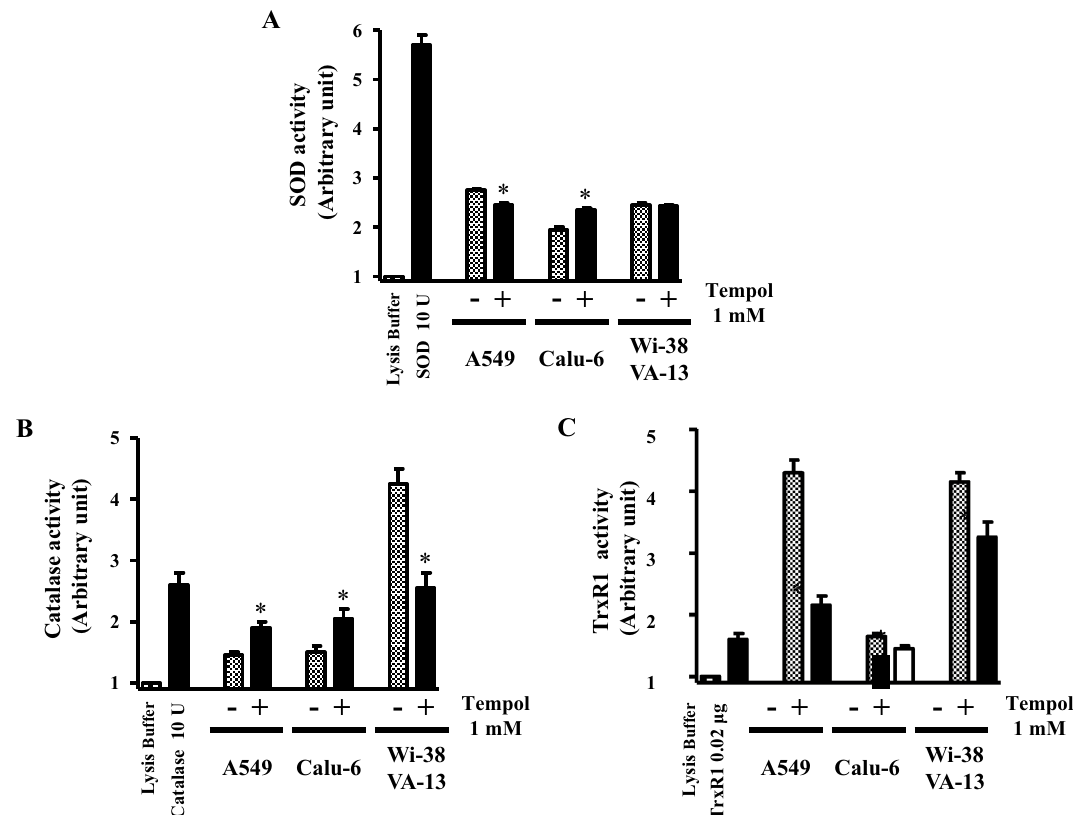
Figure 4. Effects of Tempol on SOD, catalase, and TrxR1 activity in lung cancer and normal cells. Exponentially growing cells were treated with 1 mM Tempol for 48 h. ( A ) The graph shows the activity of total SOD in arbitrary units in A549, Calu-6, and WI-38 VA-13 cells. Lysis buffer indicates a negative control in this assay. SOD 10 U indicates a positive control in this assay. ( B ) The graph shows the activity of catalase in arbitrary units in A549, Calu-6, and WI-38 VA-13 cells. Lysis buffer indicates a negative control in this assay. Catalase 10 U indicates a positive control in this assay. ( C ) The graph shows the activity of TrxR1 in A549, Calu-6, and WI-38 VA-13 cells. Lysis buffer indicates a negative control in this assay. TrxR1 0.02 μg indicates a positive control in this assay. *p < 0.05 compared with untreated